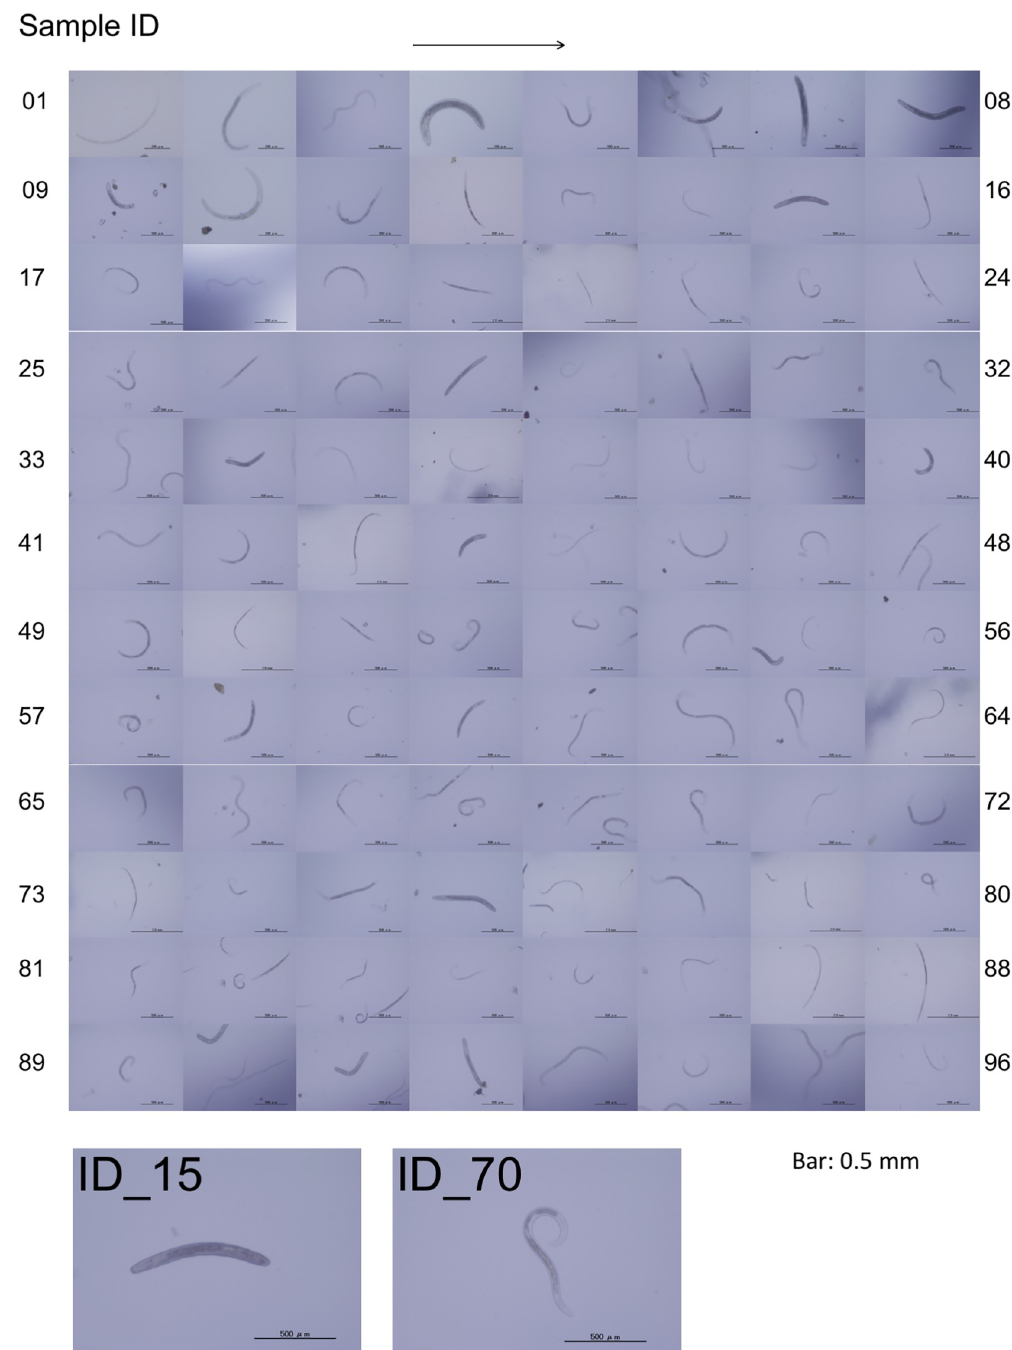
Fig 2. Images of 96 nematode isolates. Ninety-six images of nematodes are shown with their sample IDs. The sample ID numbers increase from left to right (as indicated by an arrow) and from top to bottom. Typical images for two morphologically distinct nematodes (sample ID_15 and ID_70) are shown below. Bars: 0.5 mm.